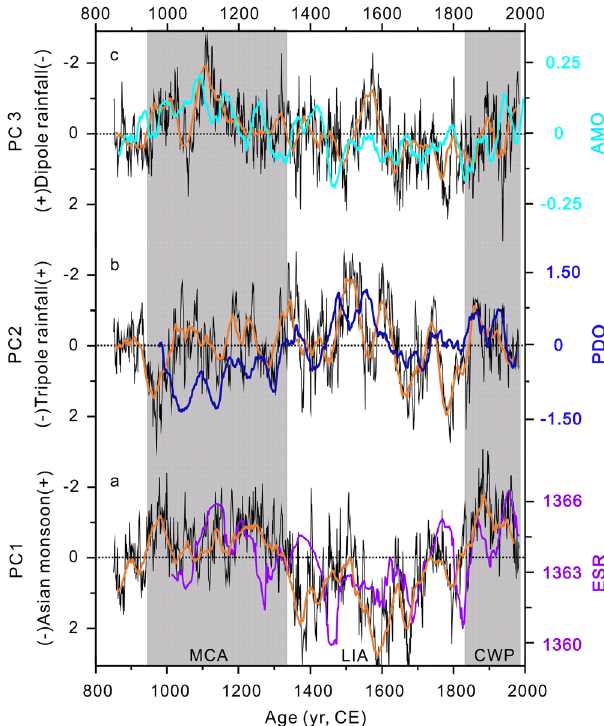
Fig. 5 The principal components analysis of three stalagmite δ 18 O records from the eastern monsoon region of China. The PC1 ( a ), PC2 ( b ), and PC3 ( c ) explain 43.28%, 32.86%, and 24.87% of the variability, representing monsoon, tripole, and dipole rainfall distribution patterns, respectively. The variations of PCs are shown in black thin curves, with their 31-year smoothing average curves shown in orange. Three principal components are consistent with the effective solar radiation 45 (ESR, purple curve), PDO 49 (31-year smoothing of the data, dark blue curve), and AMO 50 (31-year smoothing of data, light blue curve), which means internal climate dynamics persistently impact rainfall distribution in eastern China over the last millennium. The periods of MCA, LIA, and CWP are highlighted in